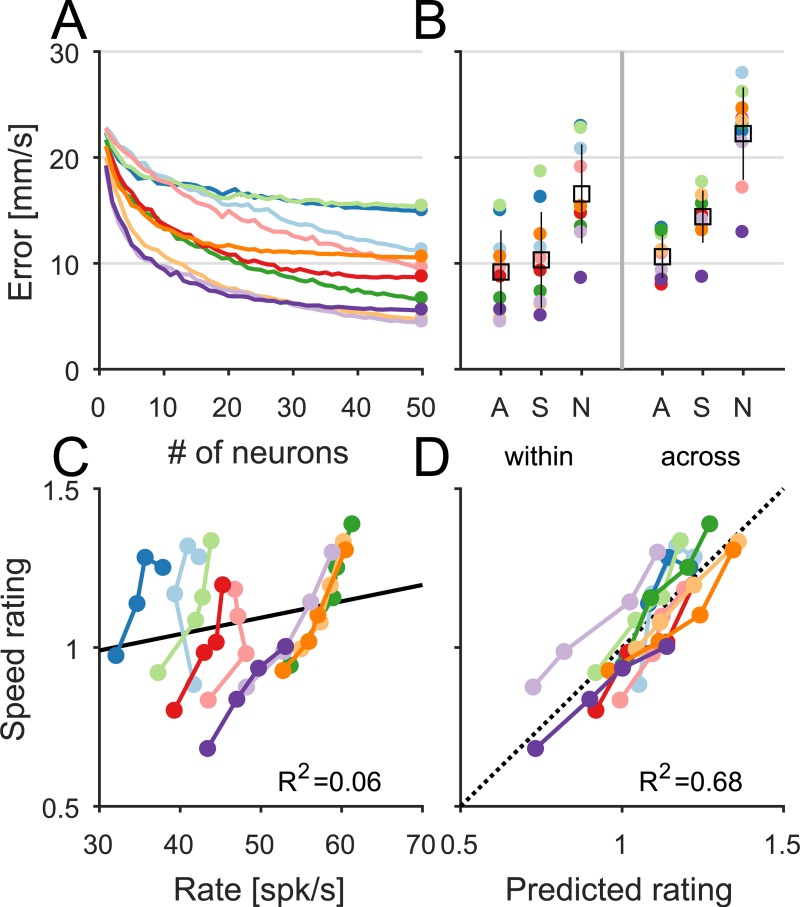
Population coding of speed in somatosensory cortex.(A) Speed decoding performance as a function of number of neurons within texture, including both speed-sensitive and speed-insensitive neurons. Each color denotes a different texture (see legend in Fig 6). (B) Speed decoding performance within (left) and across (right) textures, using A (n = 49), S (n = 25), and N (n = 24). Each colored dot is a different texture; the square and line denote the mean ± SD. (C) Speed ratings versus the mean firing rate of the entire cortical population. Each color denotes a different texture. (D) Speed rating versus the best-fitting linear combination of the mean firing rates of the two subpopulations of neurons (speed sensitive and insensitive). Data underlying this figure can be found in S1 Data. A, the entire population of neurons; N, the speed-insensitive subpopulation; S, the speed-sensitive subpopulation; spk, spike.